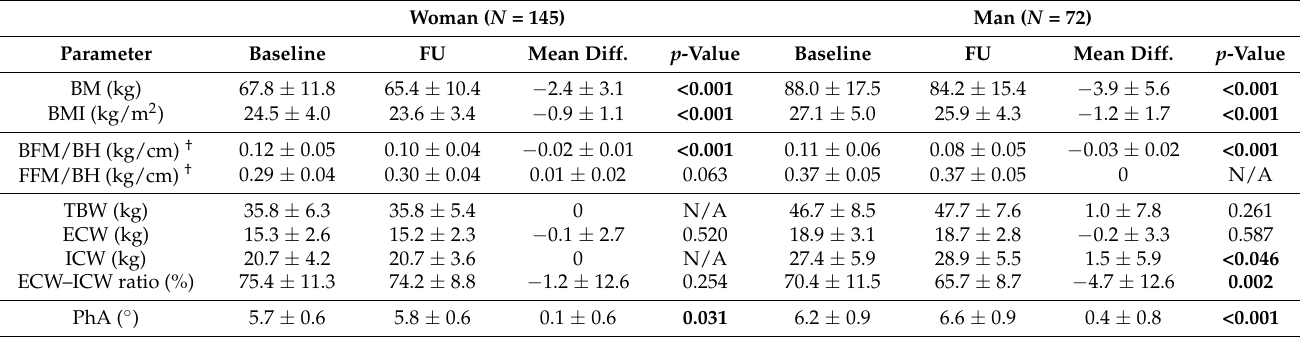
Table 2. Anthropometrics and BC indices (mean ± SD) by sex.